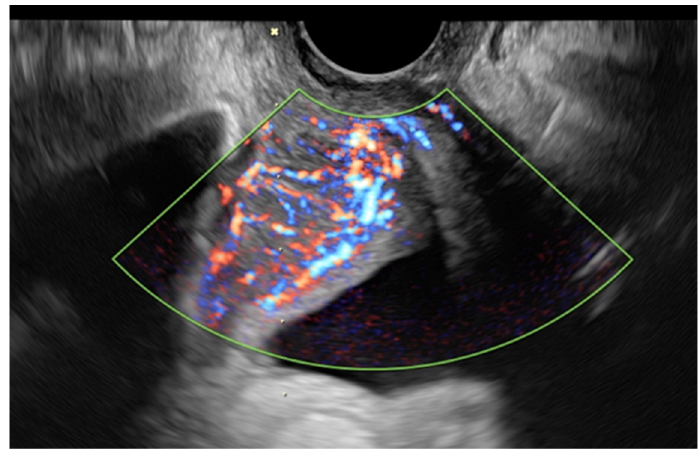
Figure 3. The US image of the pelvic B lymphoma shows a solid lesion with irregular and shaded margins and a color score of 4 between the urethra and the pubic bone.